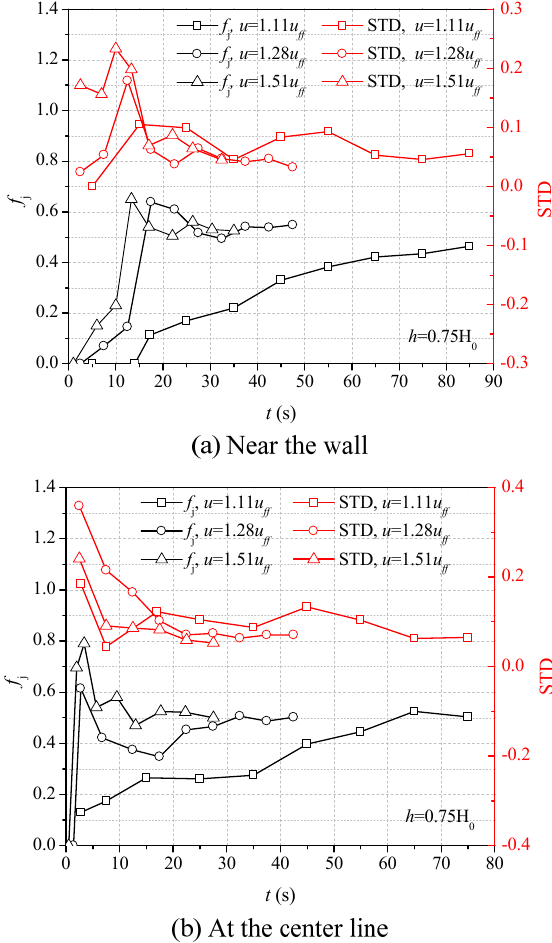
Figure 7. Variations of the micro mixing ratio and its standard deviation with time at different lateral positions under different gas velocities. ( a ) Near the wall. ( b ) At the center